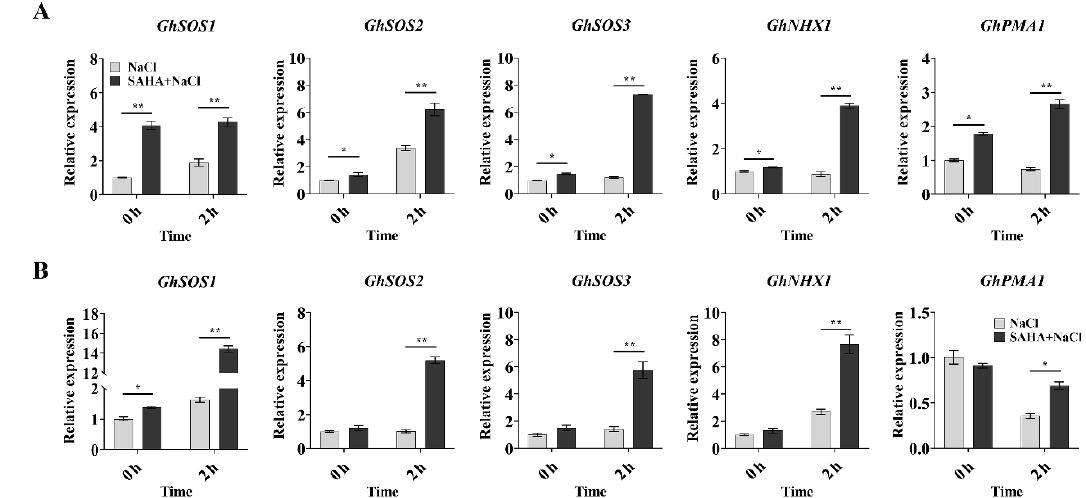
Figure 3. Expression analysis of ion homeostasis-related genes by both 10 µ M SAHA pretreatment and 250 mM NaCl stress. ( A , B ) Relative expression levels of GhSOS1 , GhSOS2 , GhSOS3 , GhNHX1 , and GhPMA1 in roots ( A ) and leaves ( B ) during 250 mM NaCl stress for 0 h and 2 h with / without 10 µ M SAHA pretreatment. GhUBQ7 ( Ubiquitin 7 ) was used as the internal control. Values represent the means ± SD of three biological replicates. Student’s t -test, * p < 0.05, ** p < 0.01.